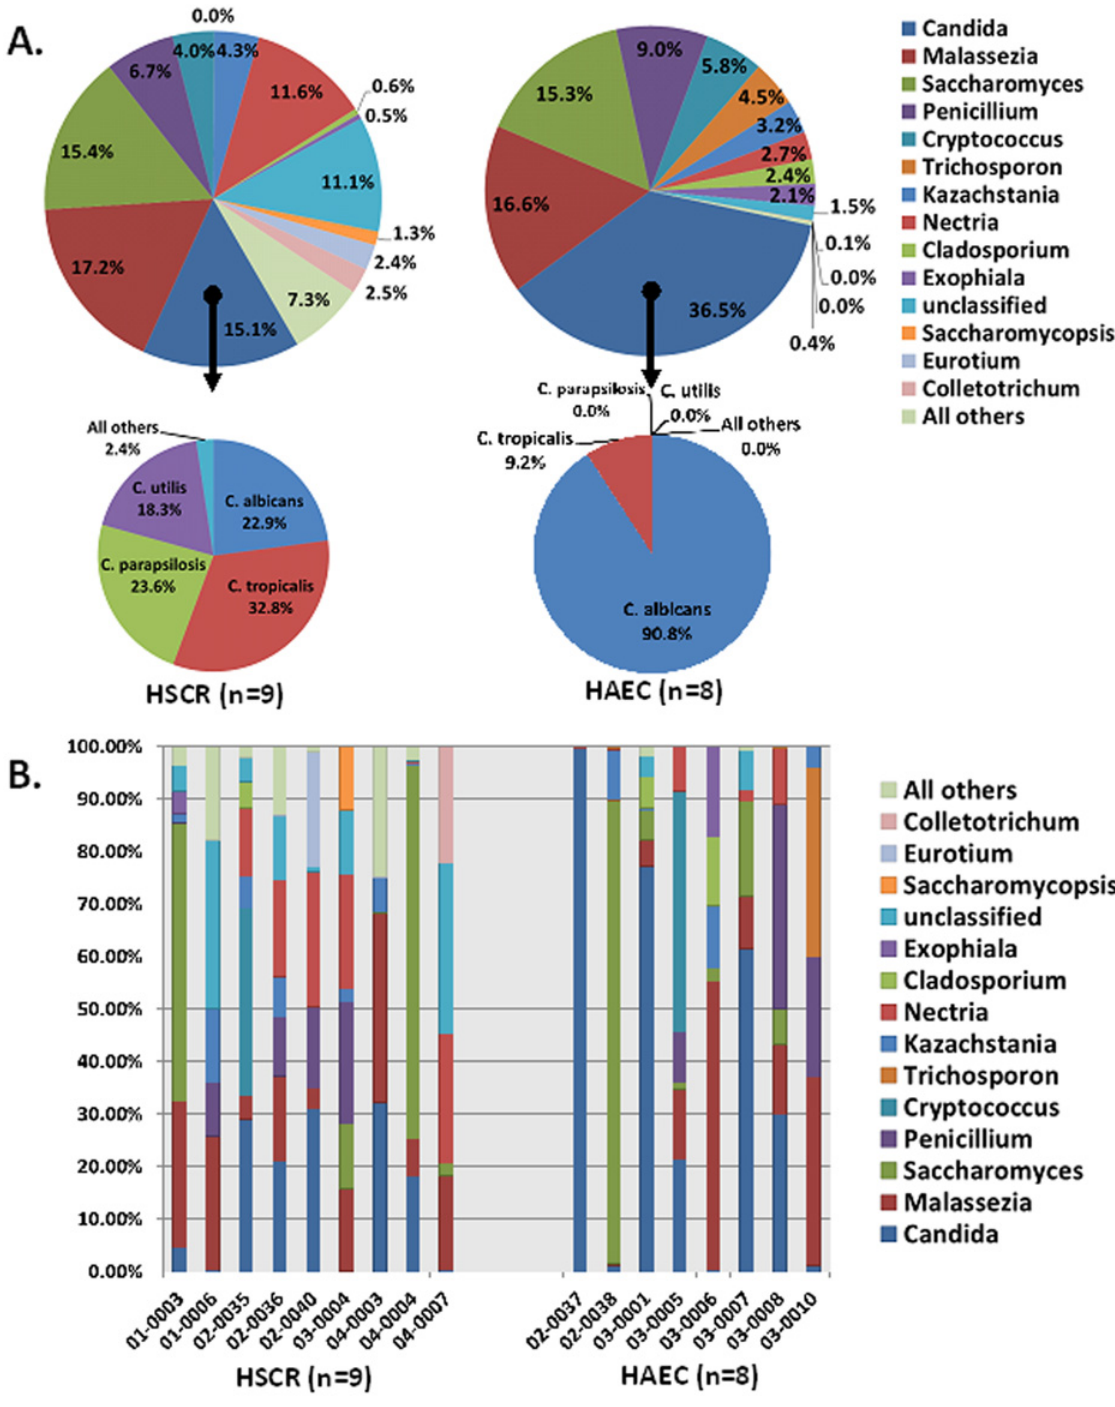
Fig 2. Fungal genera of HAEC patients have increased Candida sp . abundance compared with HSCR patients. A, Genera level distribution of fungi in nine HSCR patients and eight HAEC patients expressed as OTU abundance of 18S ITS-1 sequences (upper panel). Candida species composition in HSCR and HAEC patients (lower panel). B, Histograms demonstrating the fungal genera composition of individual subjects with HSCR and HAEC. Individual subject numbers are labeled on the X axis and expressed as relative OTUs abundance per each subject. Seventy-four different genera were identified by ITS-1 sequencing. The histogram shows 13 most abundant genera, unclassified genera, and 61 infrequent genera being summarized as “ All others ” .